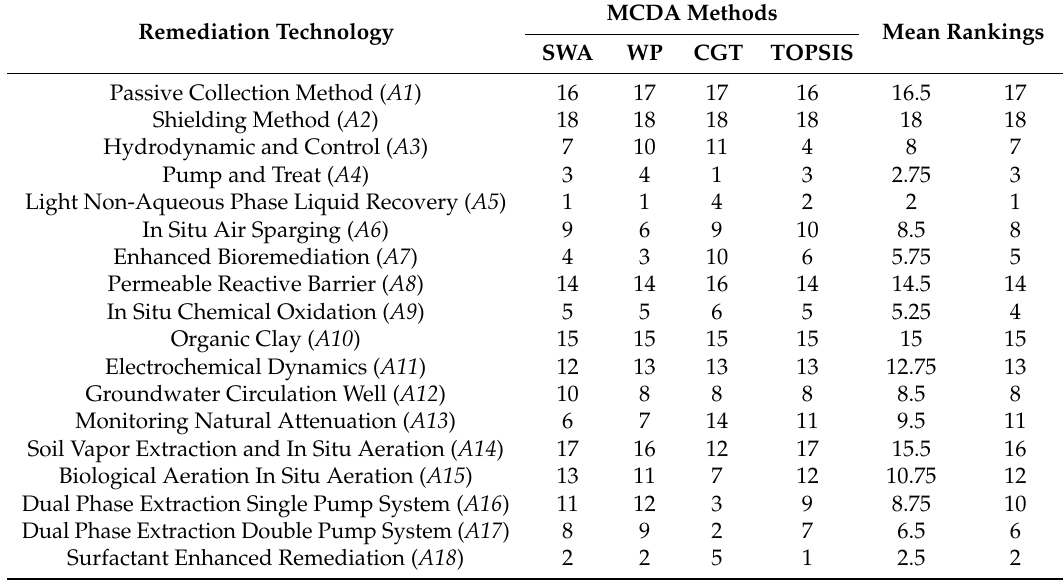
Table 8. Results of mean ranking method.